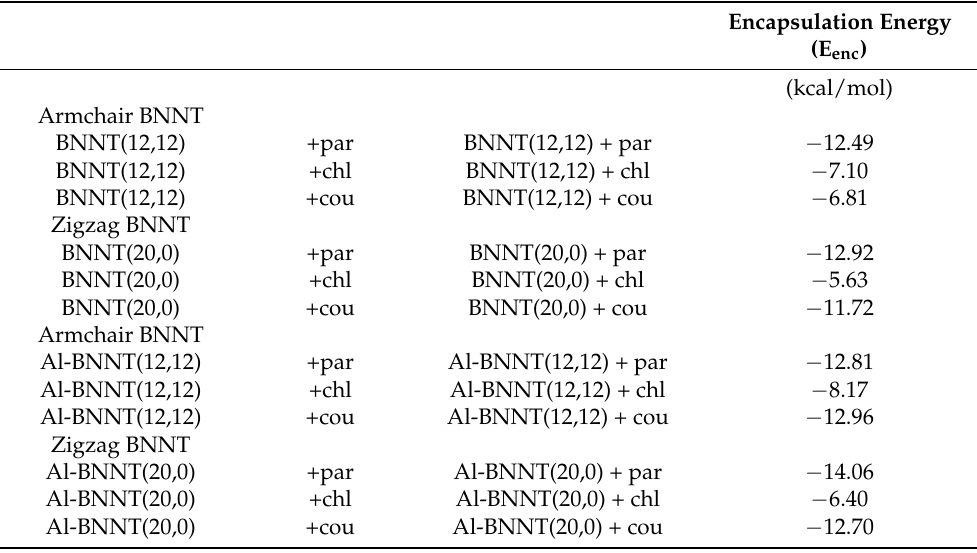
Table 1. Encapsulation energy (calculated using Equation (1), in kcal/mol) of parathion (par), chlor- pyrifos (chl), and coumaphos (cou) encapsulated by the nano-systems of BNNT(12,12),